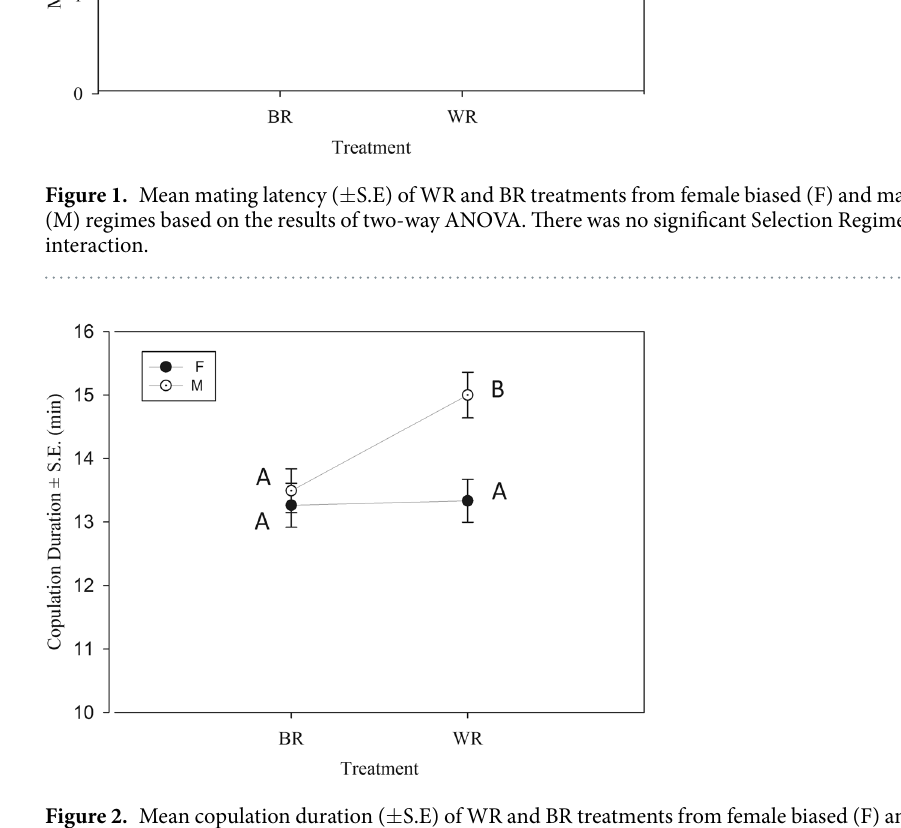
Figure 2. Mean copulation duration ( ± S.E) of WR and BR treatments from female biased (F) and male biased (M) regimes based on the results of two-way ANOVA. Points not sharing a common letter (e.g., A and B) are significantly different based on Tukey’s